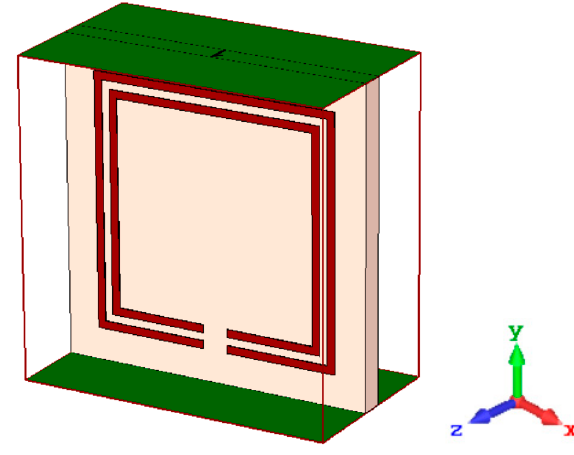
Figure 4. Boundary condition for metamaterial unit cell.